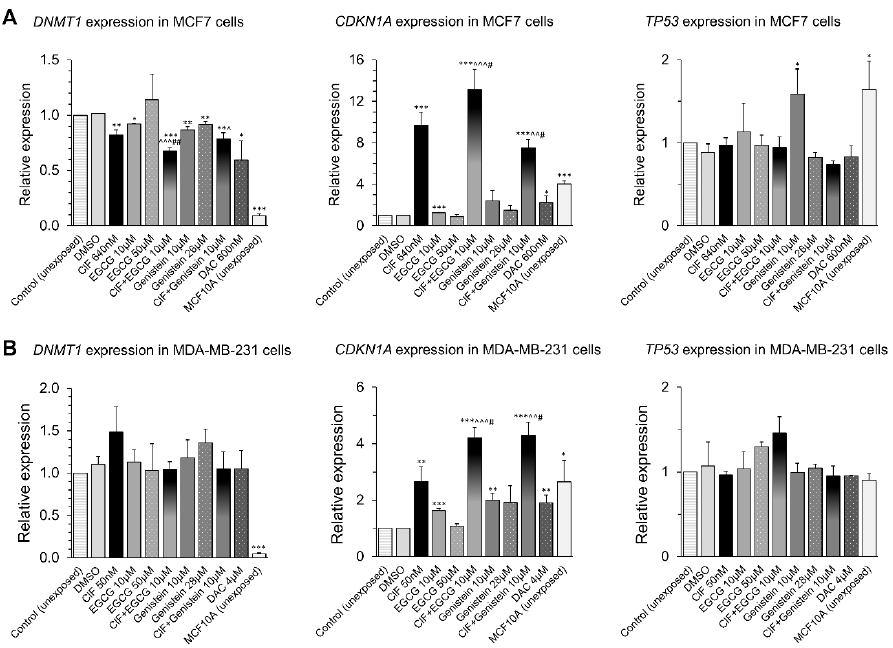
Figure 5. Effects of ClF (IC 50 ) and EGCG (10 µM) or genistein (10 µM) alone and in combination on expression of modifiers of DNA methylation reaction, DNMT1 , CDKN1A , and TP53 , in MCF7 ( A ) and MDA-MB-231 ( B ) cells. All results represent mean ± SD of three independent experiments. Exposure (ClF alone, EGCG alone, genistein alone, ClF + EGCG or ClF + Genistein) versus vehicle control, *** p < 0.001, ** p < 0.01, * p < 0.05. EGCG or genistein alone versus combinatorial exposure (ClF